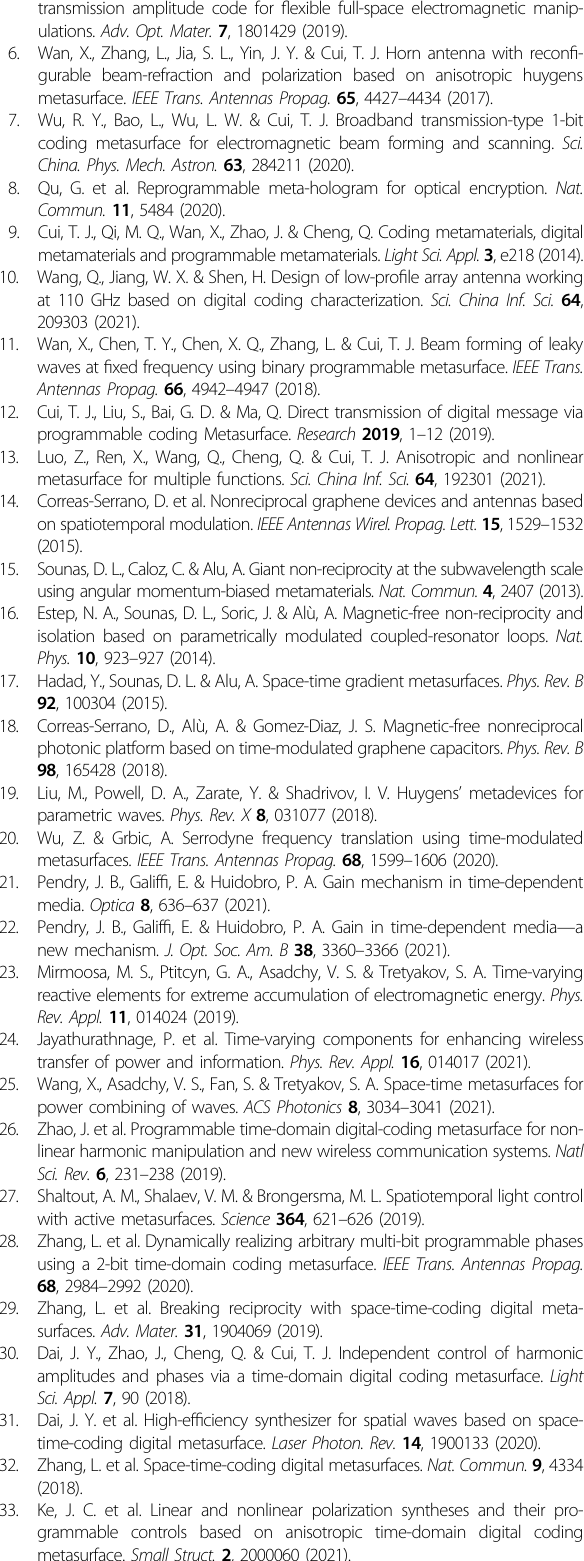
. As an example, Fig. 3g t ð Þ and the baseband waveform and h exhibit the phase φ 0 of the S-shaped FMCW with n = 1, m = 5, p = 10 and Δ f ¼ 5 T 2 T